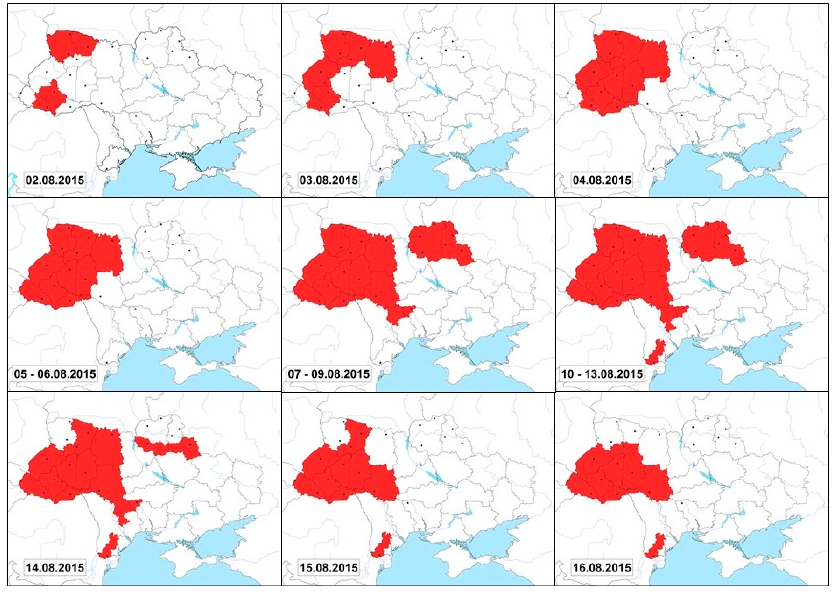
Figure 7. Date of occurrence of the HW in 2015 and the territory where it was observed.